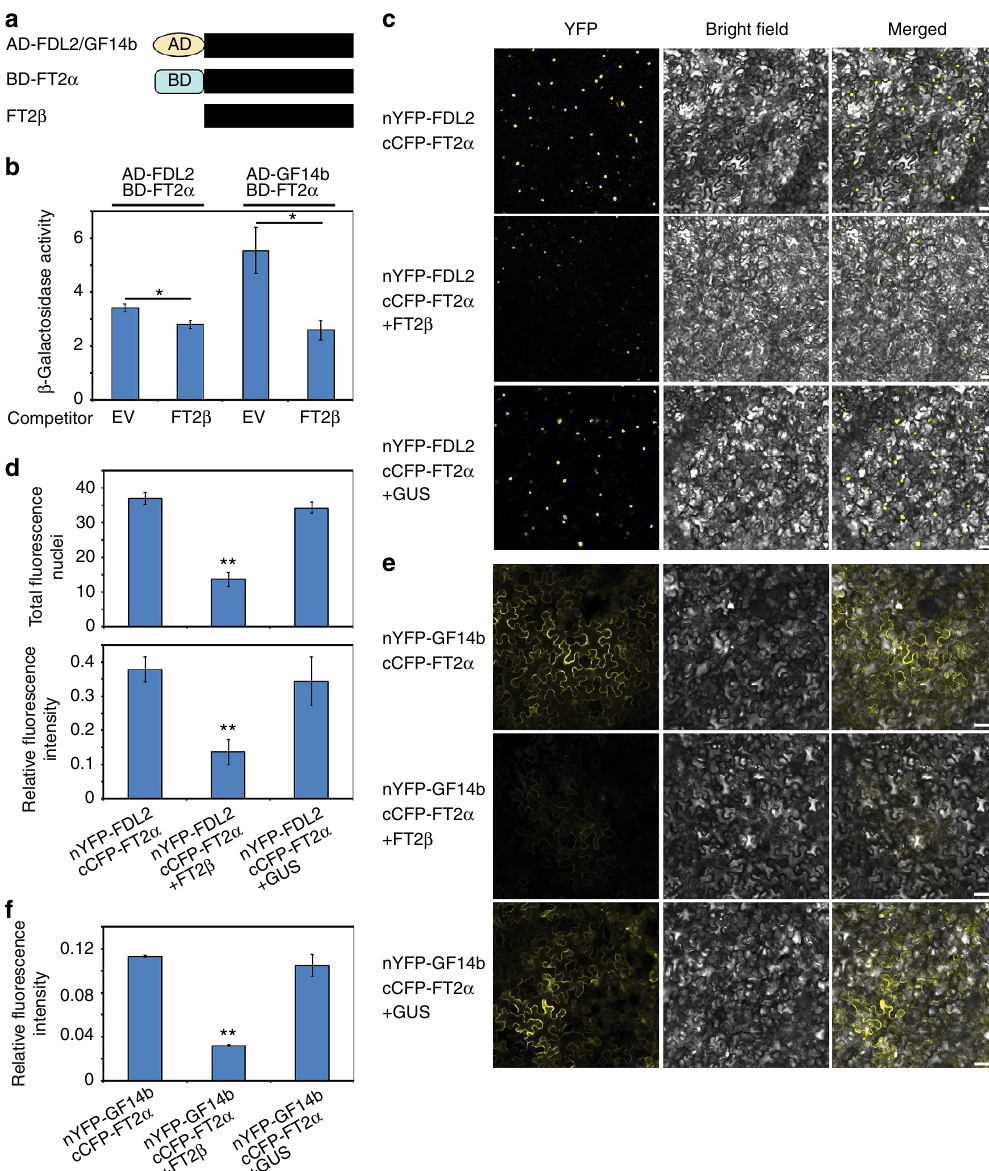
Figure 3 | Attenuation of FT2 a -binding capacity with FD-like and 14-3-3 proteins by FT2 b . ( a ) Constructs used for yeast three-hybrid assays. FT2 b was used as the competitor to the interacting proteins with activation domain (AD) and DNA-binding domain (BD). ( b ) Relative quantification of inhibition activities of FT2 b in yeast three-hybrid assays. b -Gal activities were measured in the presence or absence of FT2 b (Student’s t -test, * P o 0.05). Bars indicate s.e.m. of three replicates. EV, empty vector. ( c ) Representative photographs of fluorescence signals in BiFC assays for determination of FT2 b effects on FT2 a and FDL2 interactions in N. benthamiana leaf cells. GUS was used as a control in the absence of FT2 b . Scale bar, 50 m m. ( d ) Total fluorescence nuclei and relative fluorescence intensity in BiFC assays used for analyses of FT2 b inhibition activities to FT2 a and FDL2 interactions. Bars indicate s.e.m. of three replicates (Student’s t -test, ** P o 0.01). ( e ) Representative photographs showing the fluorescence signals in BiFC assays for determination of FT2 b effects on FT2 a and 14-3-3 interactions in N. benthamiana leaf cells. GUS was used as a control in the absence of FT2 b . Scale bar, 50 m m. ( f ) Relative fluorescence intensity in BiFC assays used for determination of FT2 b -inhibitory activities to FT2 a and 14-3-3 interactions. Bars indicate s.e.m. of three replicates (Student’s t -test, ** P o